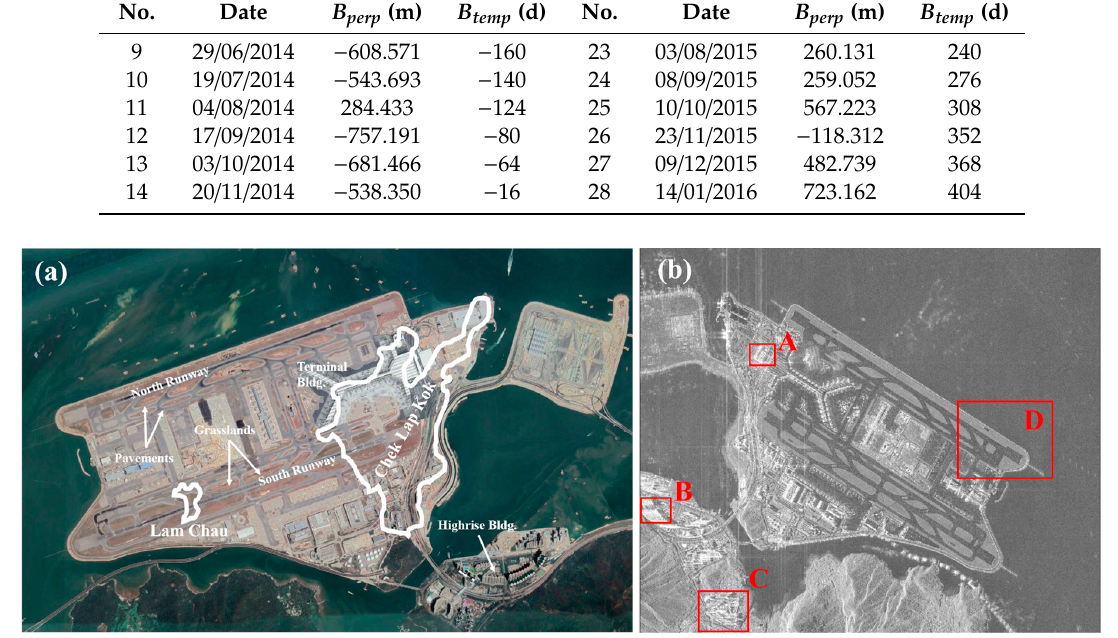
Figure 9. The Hong Kong International Airport. ( a ) Google Earth view, white polygons indicate the two original rocky islands of Chek Lap Kok and Lam Chau. ( b ) Mean amplitude map of the CosmoSkyMed dataset, red boxes are regions for the detailed phase comparison in Figure 10.